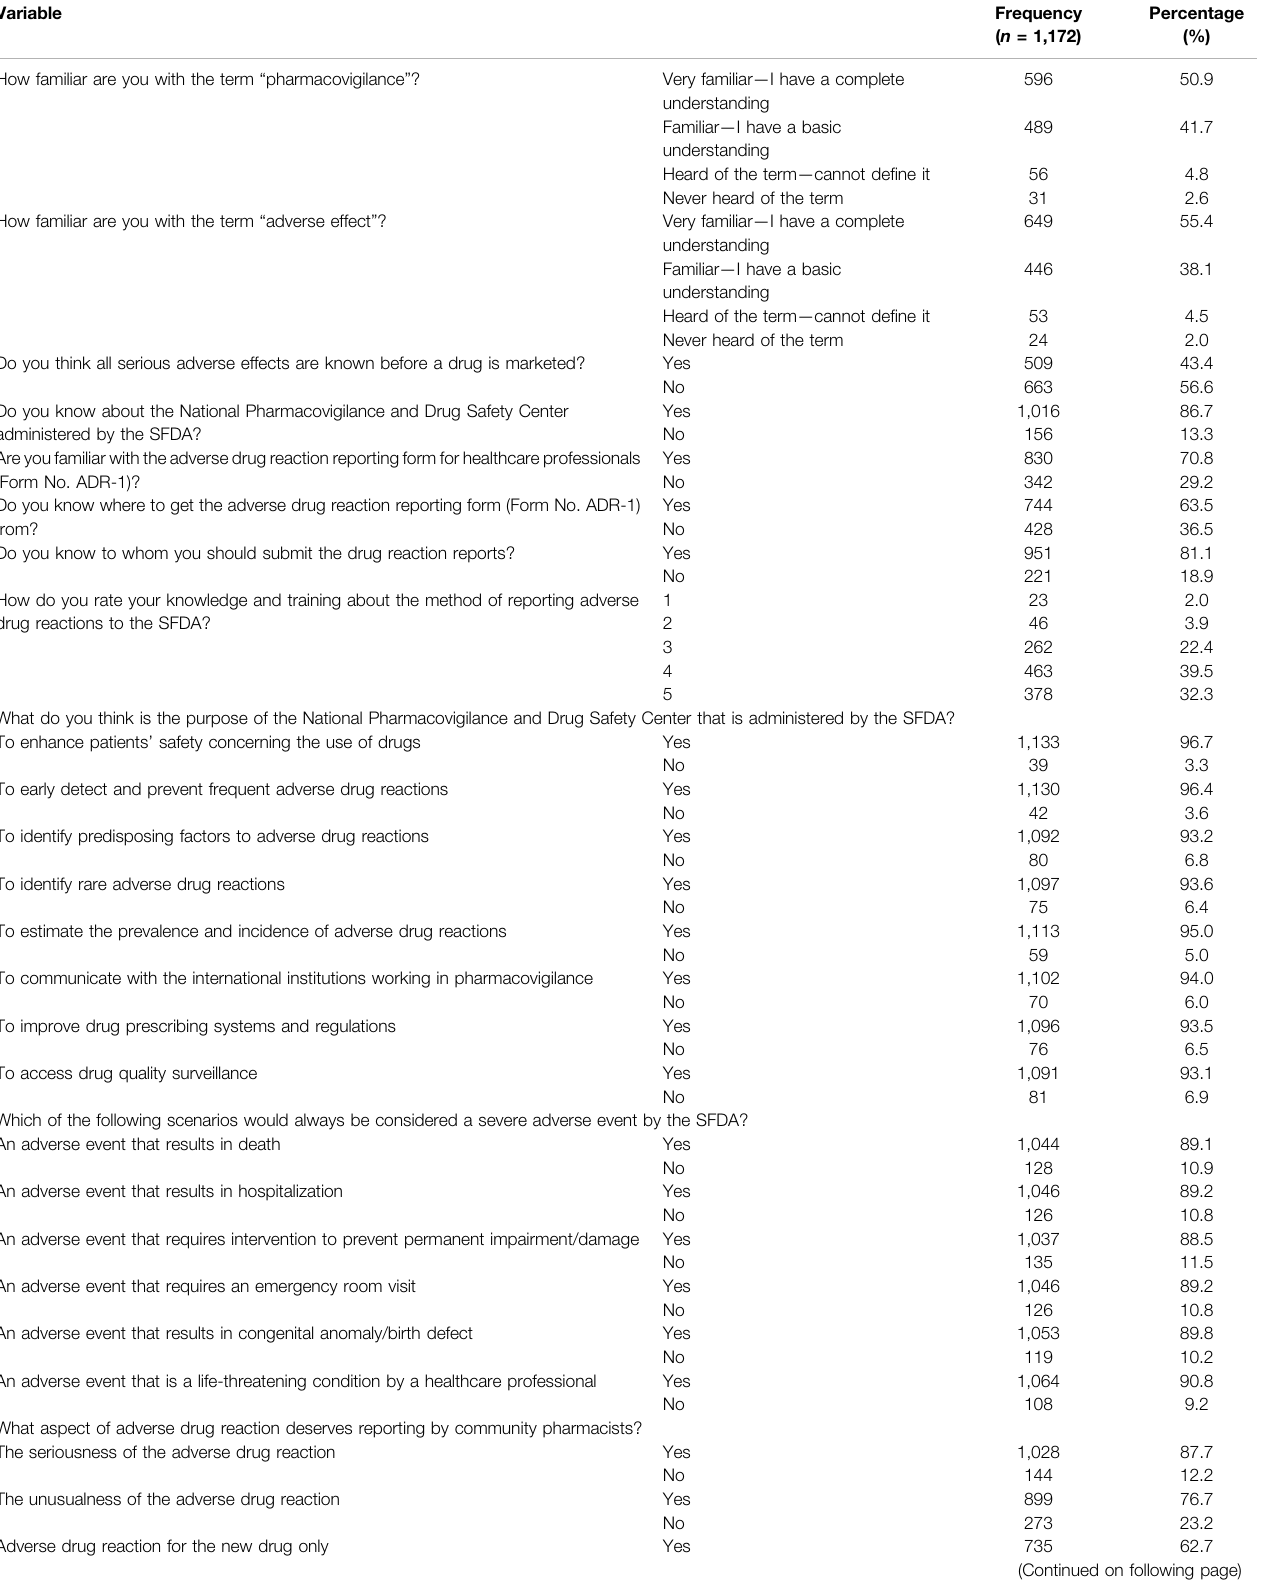
TABLE 2 | Pharmacovigilance and ADR reporting related knowledge of the